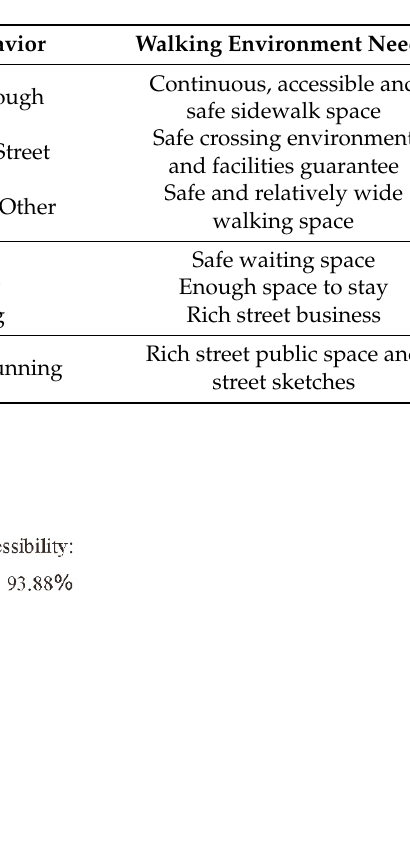
Table 4. Analysis of characteristics of children’s school travel activities and walking environment demand.